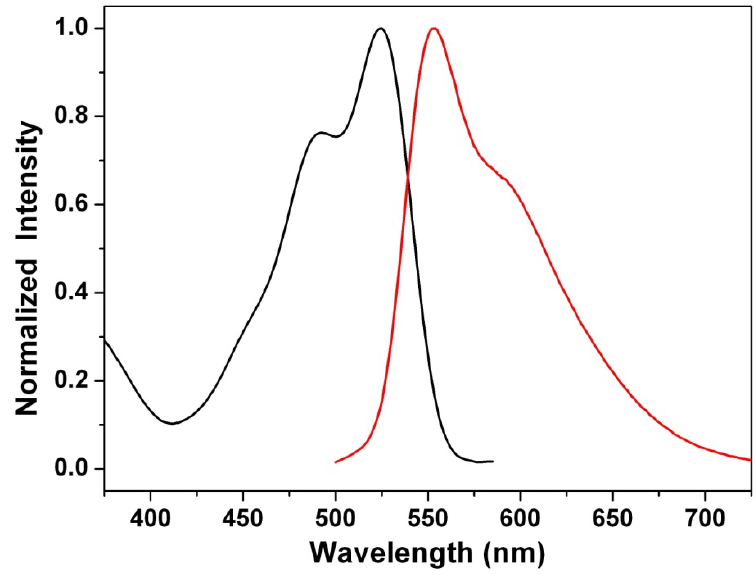
Figure 10. The absorption (black line) and emission (red line) spectra of 1a in concentrated